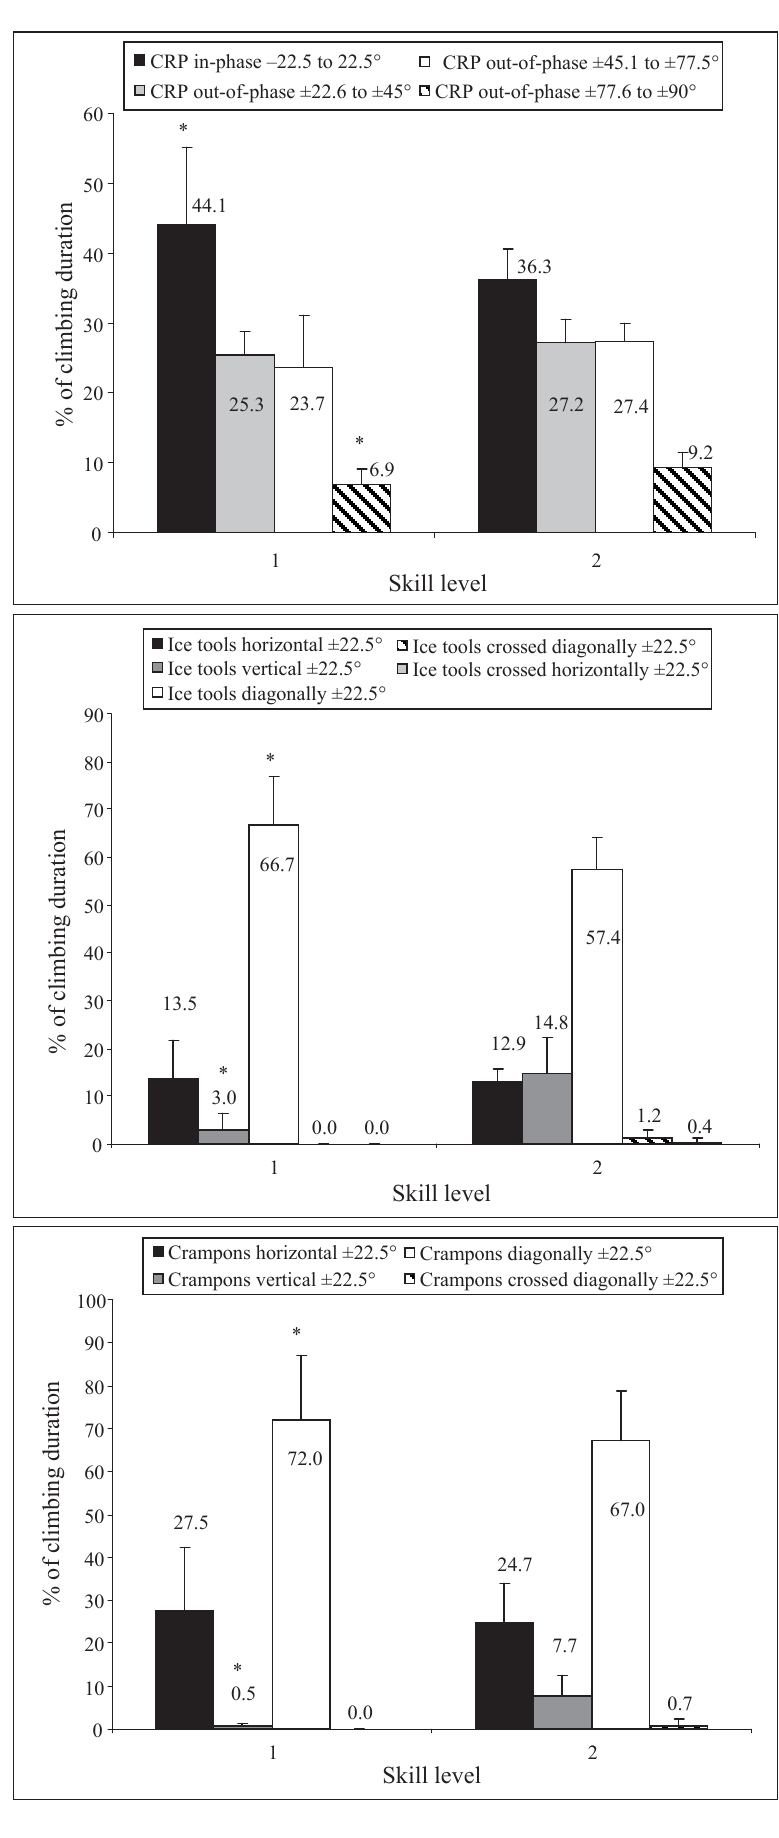
Figure 4. Continuous Relative Phase (CRP) spent in in-phase and out-of-phase mode